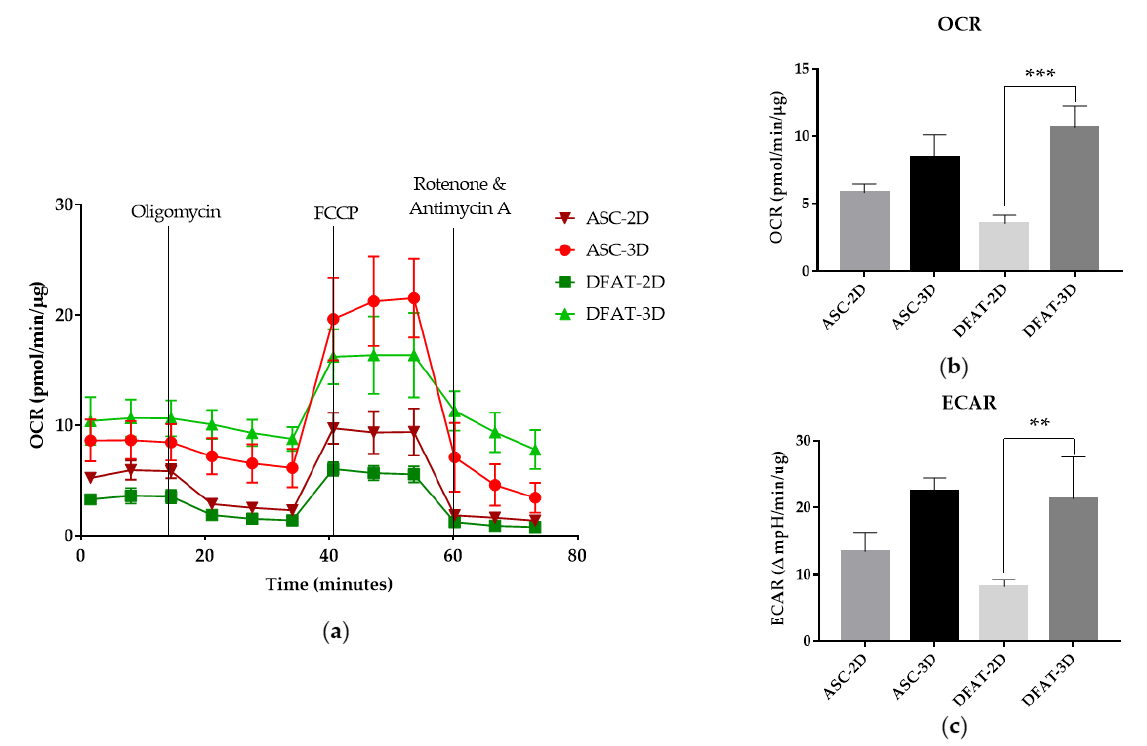
Figure 8. Metabolic phenotype evaluation by Seahorse XF HS Mini. ( a ) The kinetic graph of oxygen consumption rate (OCR) in time. ( b ) OCR mean values of basal respiration. ( c ) The extracellular acidification rate (ECAR) mean values of basal respiration. The results are presented as a mean value of 3 experiments ± SD and are normalized per µg of protein for ** p < 0.01, *** p < 0.001. The basal OCR was recorded at 8.4 ± 1.6 pmol/min/ µ g for ASCs-3D, while 5.8 ± 0.6 pmol/min/ µ g for ASCs-2D. Moreover, O 2 consumption per minute was also significantly faster in DFATs-3D than in DFATs-2D, reaching 10.6 ± 1.6 pmol/min/ µ g in comparison